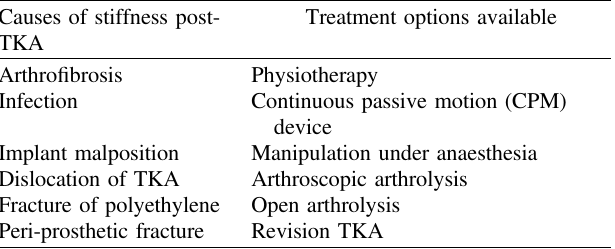
Table 1. Causes of stiffness following TKA and treatment options. Causes of stiffness post-